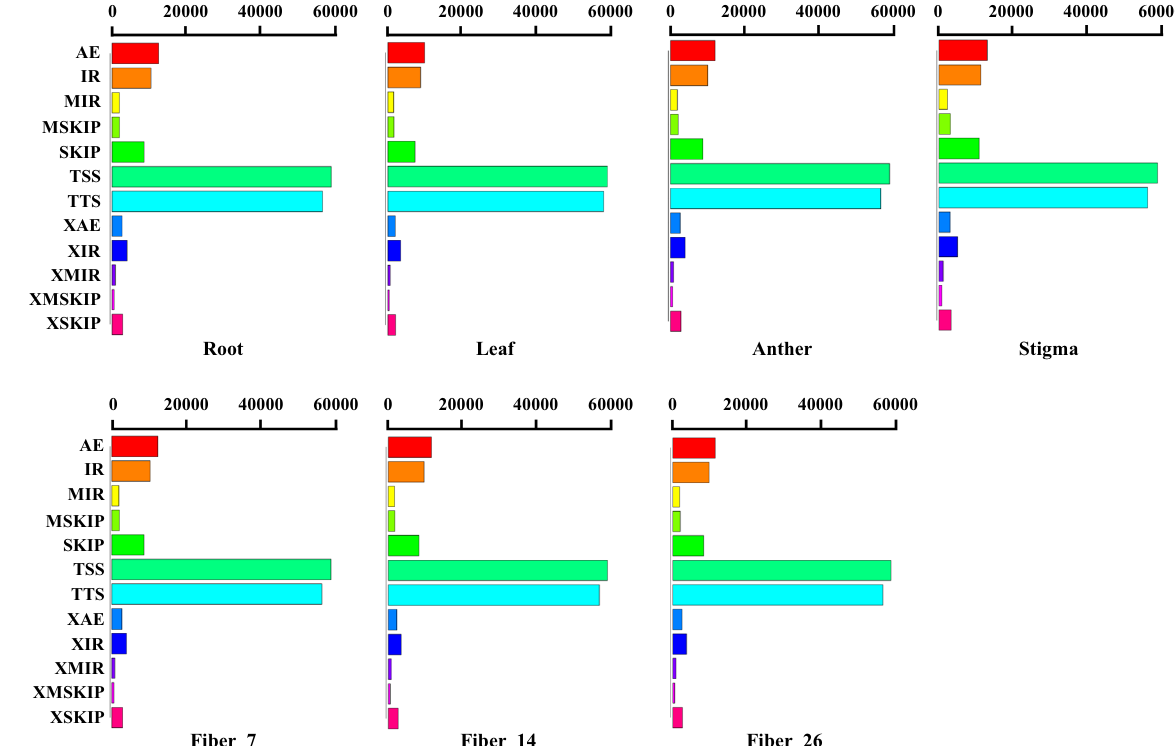
Figure 2. Types and numbers of variable splicing statistics. AE Alternative exon ends, IR intron retention, MIR multi-IR, MSKIP multiexon SKIP, SKIP skipped exon, TSS alternative 5 ′ first exon, TTS alternative 3 ′ last exon, XAE approximate AE, XIR approximate IR, XMIR approximate MIR, XMSKIP approximate MSKIP, XSKIP approximate